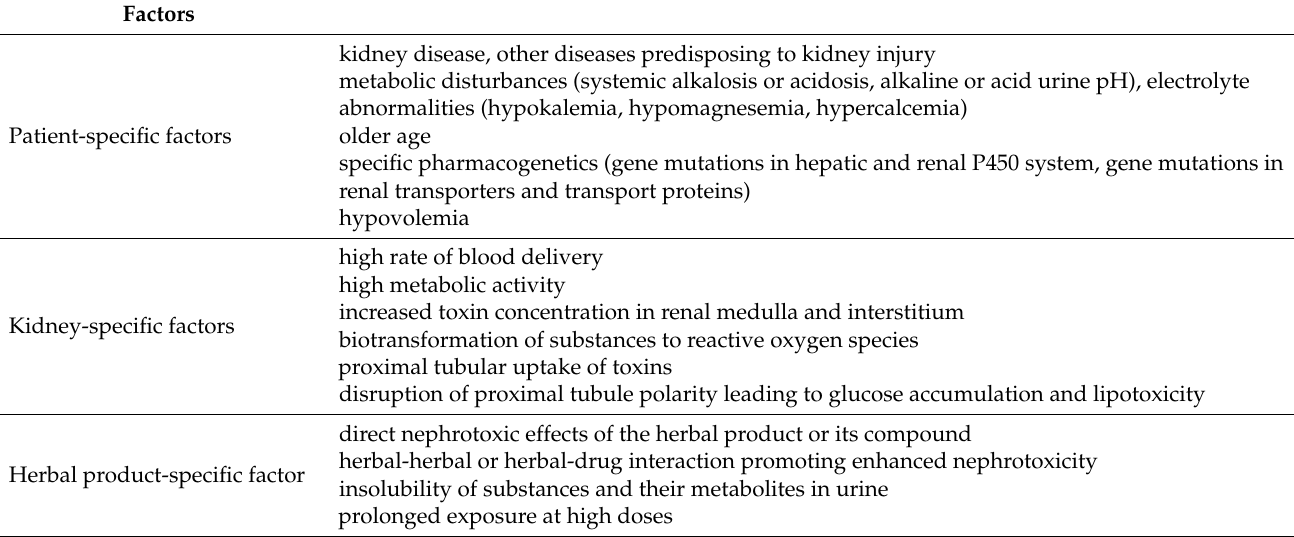
Table 1. Risk factors that increase renal susceptibility to nephrotoxins.